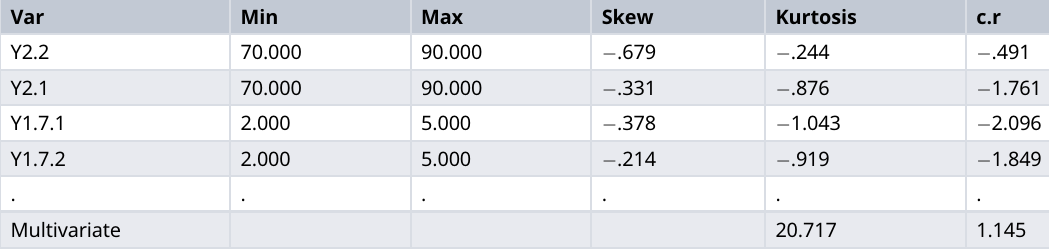
Table 2. Assessment of normality after data outlier cleaning had been